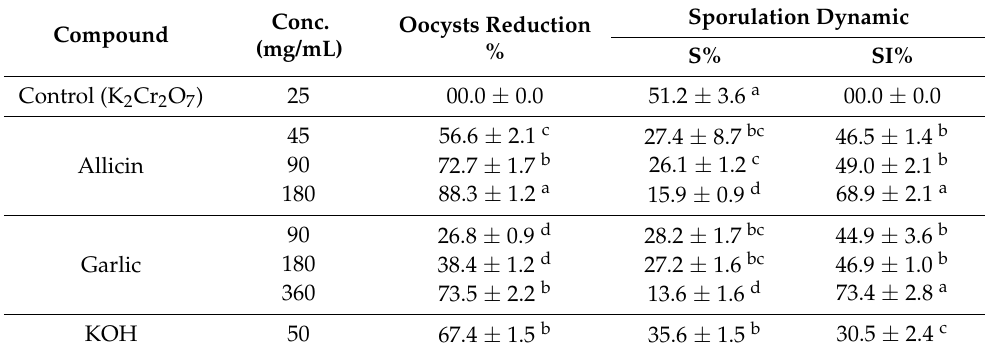
Garlic KOH 30.5 ± 2.4